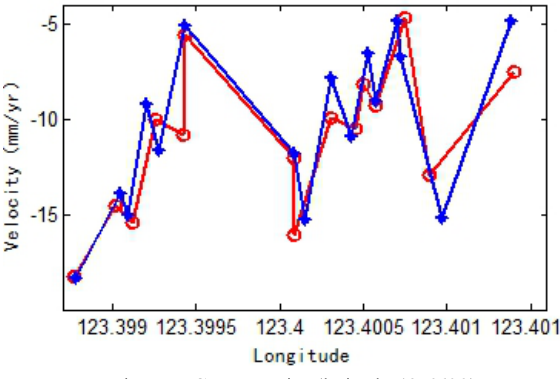
Figure.5 Cross-section(latitude